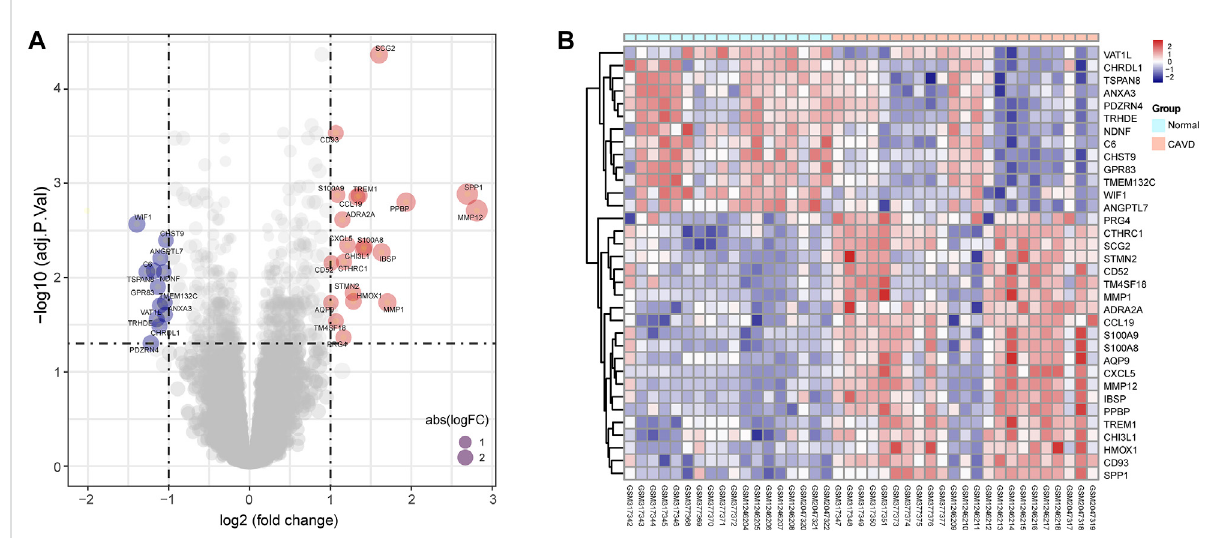
FIGURE 2 Differentially expressed genes (DEGs) between calci fi c aortic valve disease (CAVD) and normal aortic valve samples. (A) Volcano plot showing DEGs between CAVD and normal groups after combined analysis of GSE12644, GSE51472, and GSE77287 datasets with R software. The x -axis represents the fold change (log scaled), and the y -axis represents adjusted p -value (log-scaled). Red dots represent upregulated genes, blue dots representdownregulatedgenes,andsizeofdotsrepresentthefoldchangeofgeneexpression. (B) HeatmapshowingDEGsbetweenCAVDand normalgroups.Upregulatedgenesareinred;downregulatedgenesareinblue.Thesamplesclusteredinlightbluearenormalaorticvalvegroup,and the samples clustered in light red are CAVD